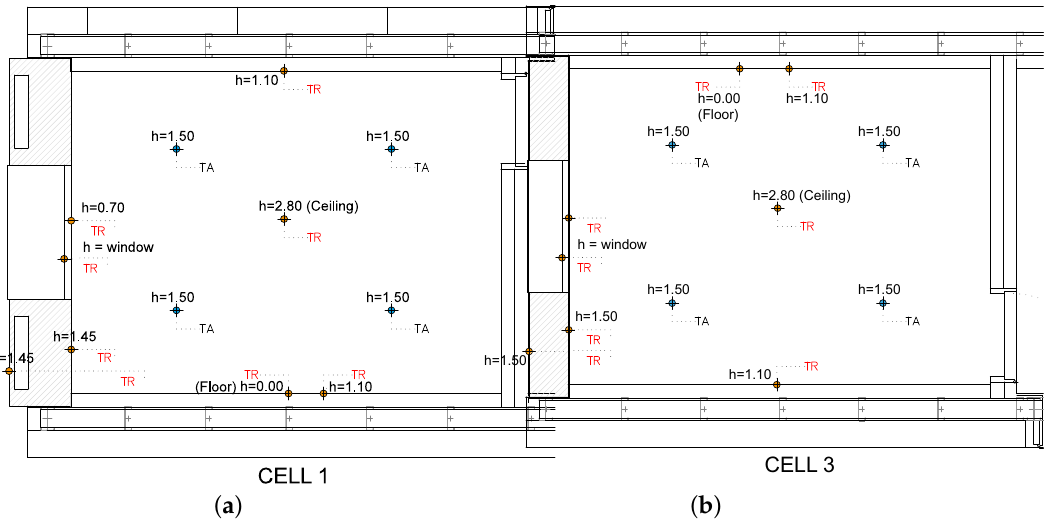
Figure 4. Location of the sensors in: ( a ) test cell 1; ( b ) test cell 3. (TA air temperature sensors, TR surface temperature sensors; h indicates the height in